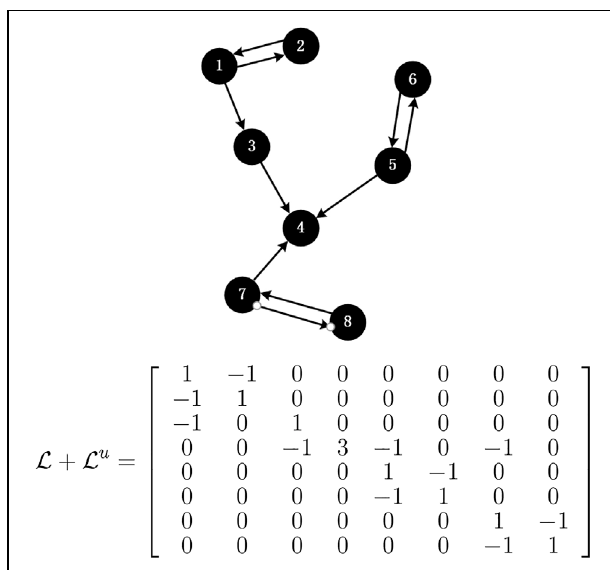
FIGURE 10 | Time evolution plot of x